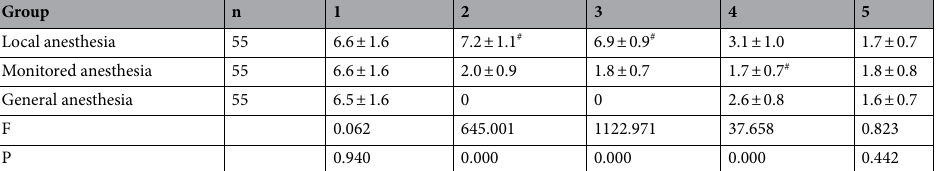
Table 2. Visual analogue score (x ± s). # Statistical difference among three groups (P < 0.05). Repeated Measures Anova was used in three or two group comparisons. 1: 1 h before anesthesia; 2: puncture of trocar into vertebral body; 3: injection of bone cement into vertebral body; 4: 2 h after operation; 5: 1 day after operation. F: F test value.